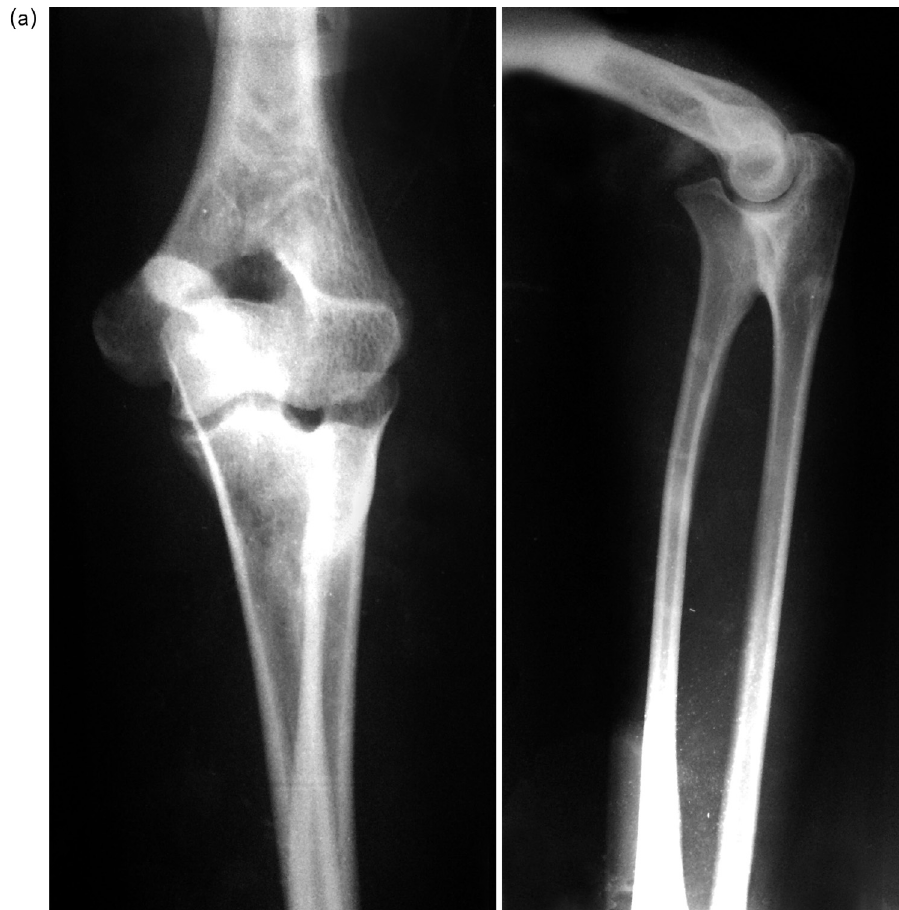
Figure 1. (a) and (b) Bilateral preoperative anteroposterior and lateral radiographs of elbows (Case no. 1), showing proximal radioulnassynostosis with radial head displaced anteriorly consistent with a type-IV deformity